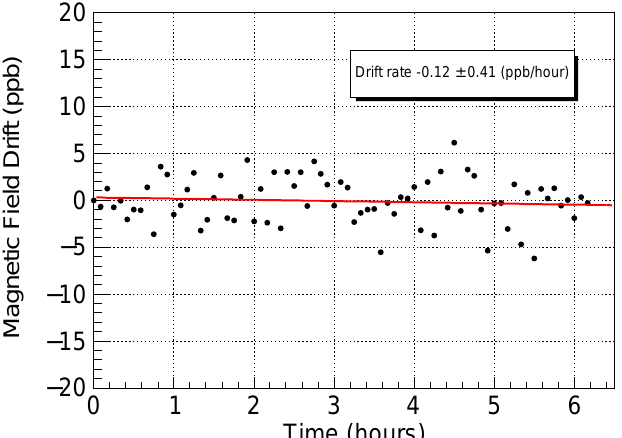
Figure 10. Measurement of the magnetic field drift with the 3 He NMR Probe. NMR signal is taken every 5 min and fitted by a Lorentzian function to determine the magnetic field. The absolute magnitude of the field is 5.3 Tesla. The measured drift rate here, just two weeks after the solenoid was charged, is thus − 0.12 ± 0.41 ppb/h. Longer term drifts have yet to be